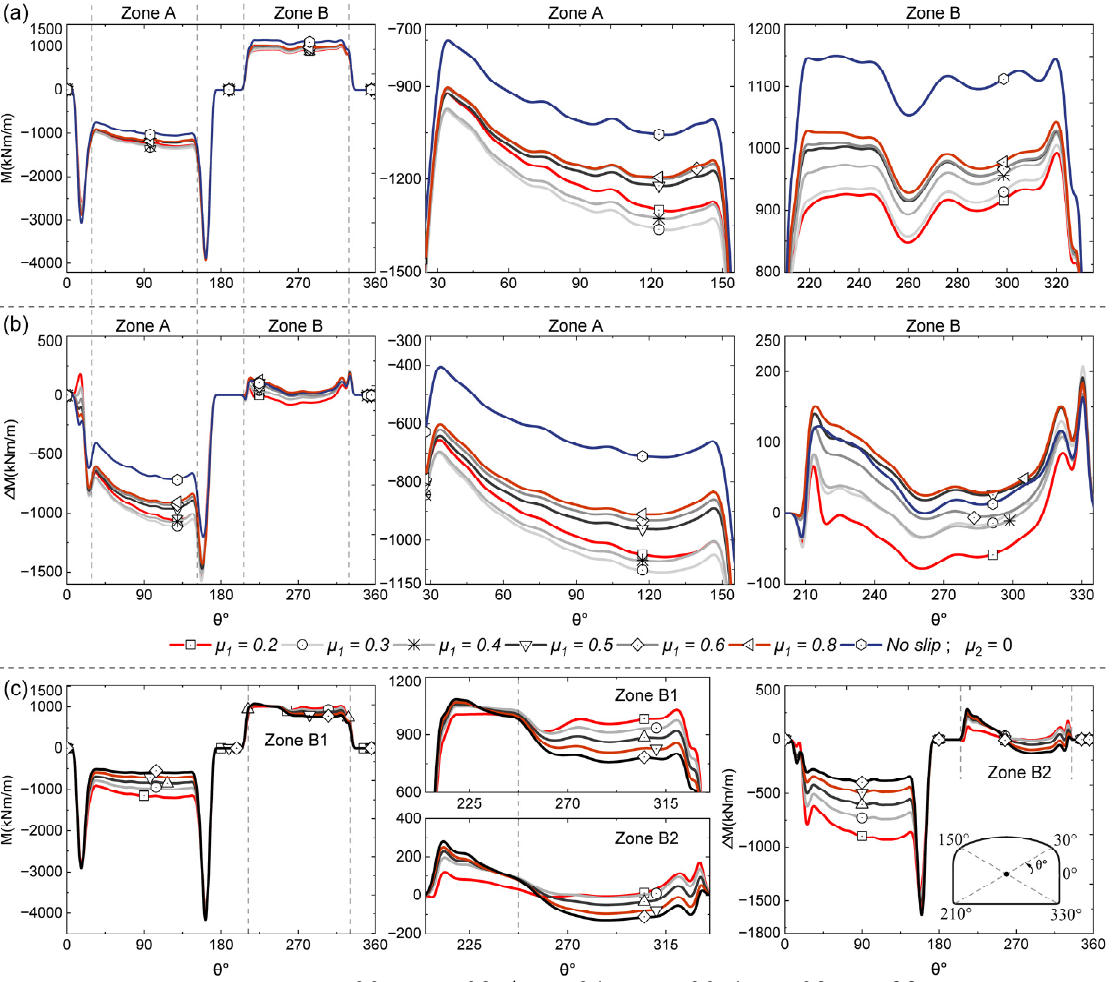
Figure 17. Effect of interface characteristics on bending moment ( a ) tunnels without and with primary lining ( b ) tunnels with primary lining; μ 1 = 0.2, 0.4, 0.6, 0.8 and no-slip; μ 2 = 0 ( c ) tunnels with primary lining; μ 1 = 0.6; μ 2 = 0.2, 0.4, 0.6, 0.8.